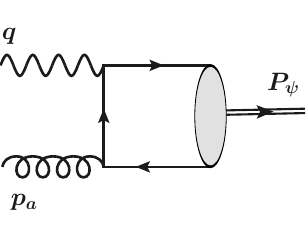
Figure 3 . Feynman diagram for the process γ ∗ ( q ) + g ( p a ) → J/ψ ( P ψ ) contributing to J/ψ pro- duction in SIDIS at the order αα s . The crossed diagram, in which the directions of the arrows are reversed, is not